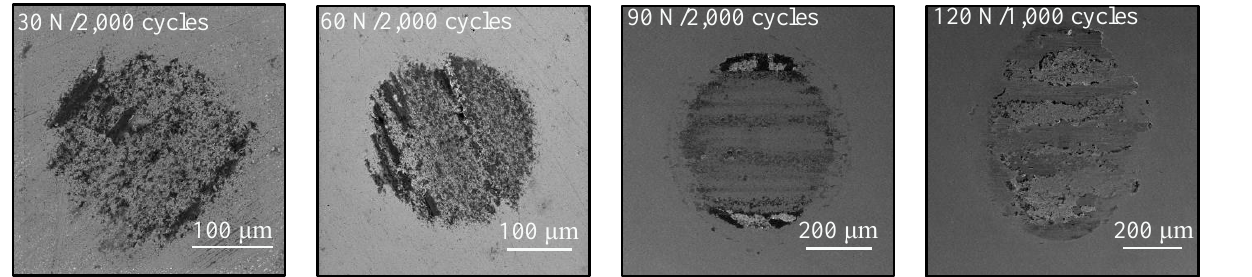
Figure 16. Wear scar of the counterbody against the AlTiN-coated WC-Co substrate under different condition.